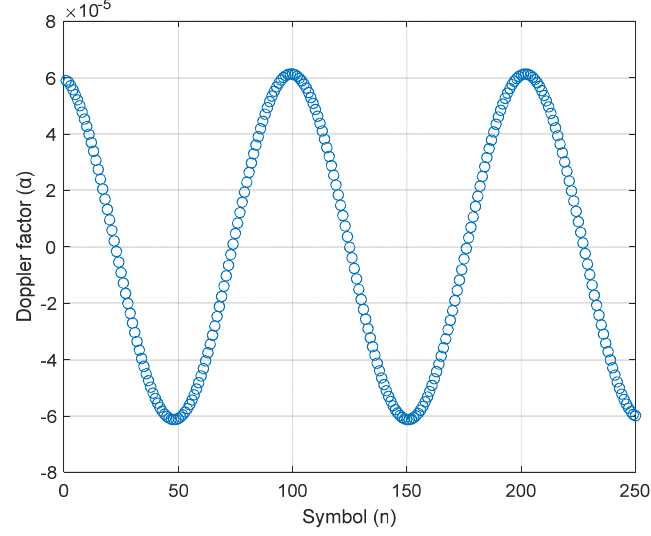
Figure 9. Doppler factor per symbol.